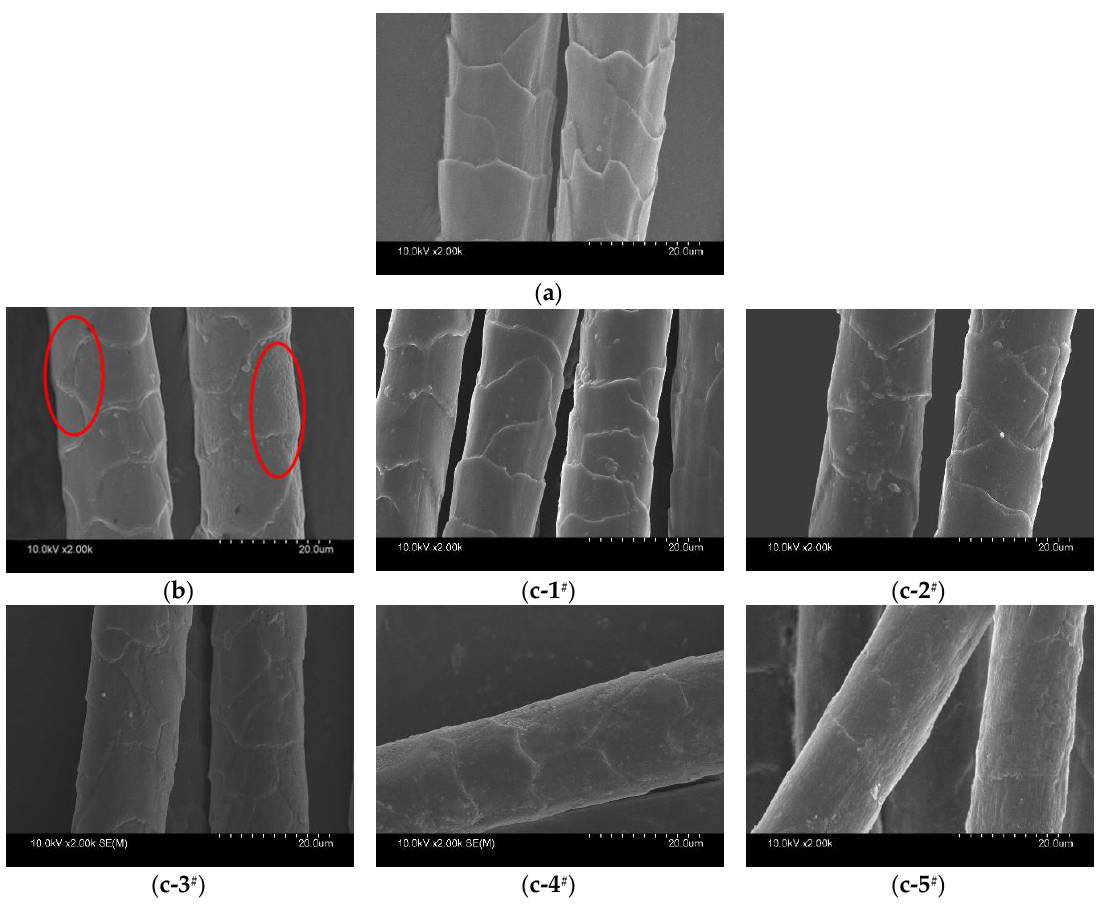
Figure 3. SEM images of wool fibers ( a ) control ( b ) exhaustion treated with 1 mL/L Savinase 16L and 2 mL/L activator, at 50 °C, pH 8.0, bath ratio 100:1 for 2.5min and ( c-1 # )–( c-5 # ) Padding treated with 1 mL/L Savinase 16L and 2 mL/L activator, at 50 °C, pH 8.0, ( c-1 # ) Padded 1 time,…, ( c-5 # ) Padded 5 times.